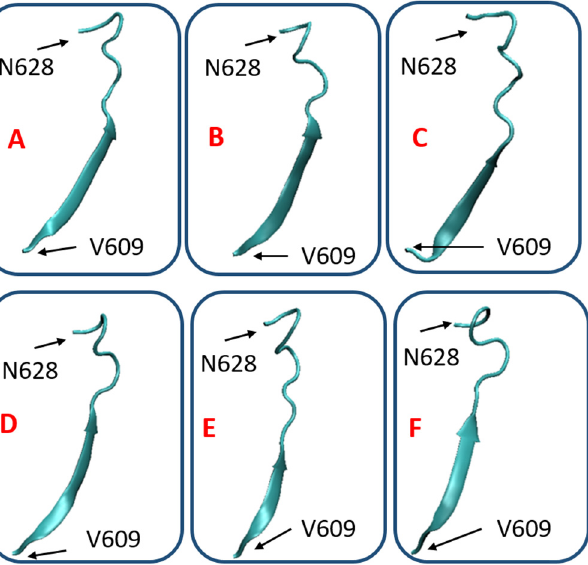
Figure 3. Structural variations of motif A of nsp12 (region: V609-N628) in nbGTP ( A ), G24 ( B ), G23 ( C ), nbPENT ( D ), PEN24 ( E ), and PEN23 ( F ) complexes.